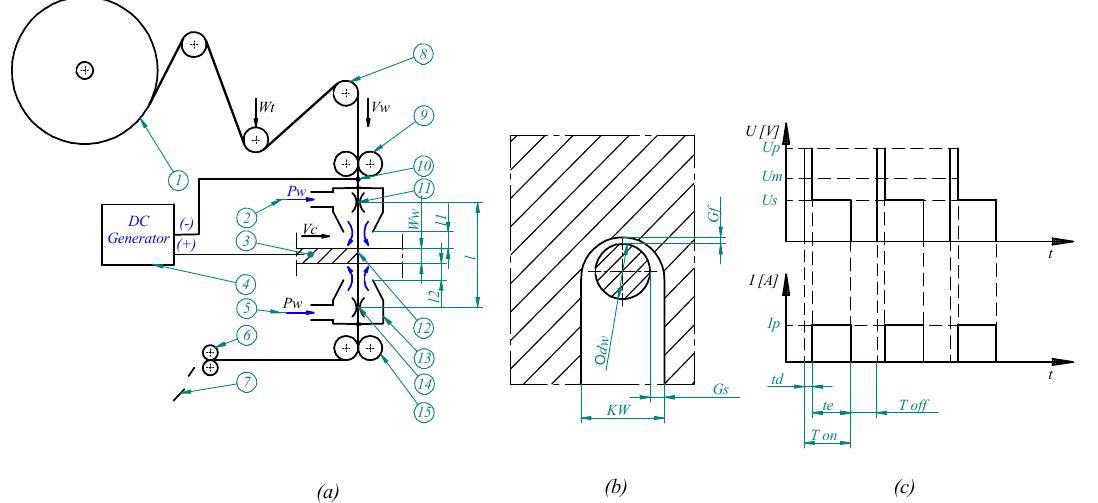
Figure 1. Wire electrical discharge machining components: ( a ) scheme of the process, ( b ) view of the wire in the kerf, ( c ) graph of current impulse run, 1—wire reel, 2—upper inlet of flushing liquid (dielectric), work piece, 4—supply unit, 5—lower inlet of flushing dielectric, 6—wire chopper, 7—cut wire scrap, 8—rolls of wire tensioning unit, 9—upper wire drive, 10—current pick up, 11—upper wire guide 12—wire, 13—the nozzle of lower flushing, 14—lower wire guide, 15—bottom wire drive, Vw—wire feeding, Wt—wire tension, Vc—workpiece feed, Pw—flushing water pressure, Ww—workpiece width, l—distance before guides, l1—upper flushing die gap, l2—lower flushing die gap,